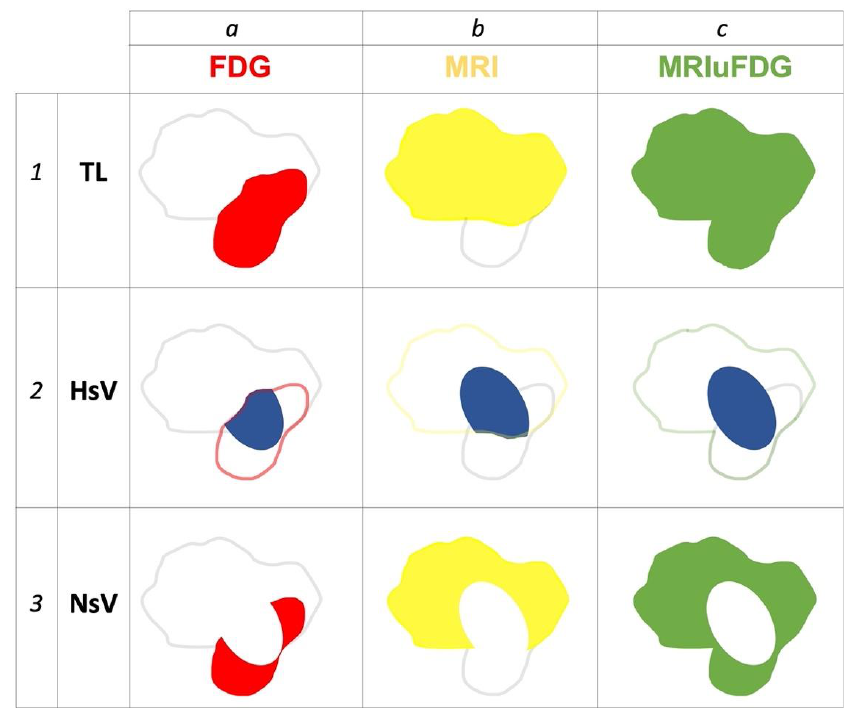
Figure 1. Example of different segmentations obtained from a patient included in the RTEP8- Hyponeck study. Columns a, b, and c represent FDG PET (red), MRI (yellow), and the union of MRI and FDG PET (green), respectively. Lines 1, 2, and 3 represent the segmentations of the tumor lesion (TL; solid color), hypoxic (HsV; blue color), and normoxic (NsV; white color) subvolumes.